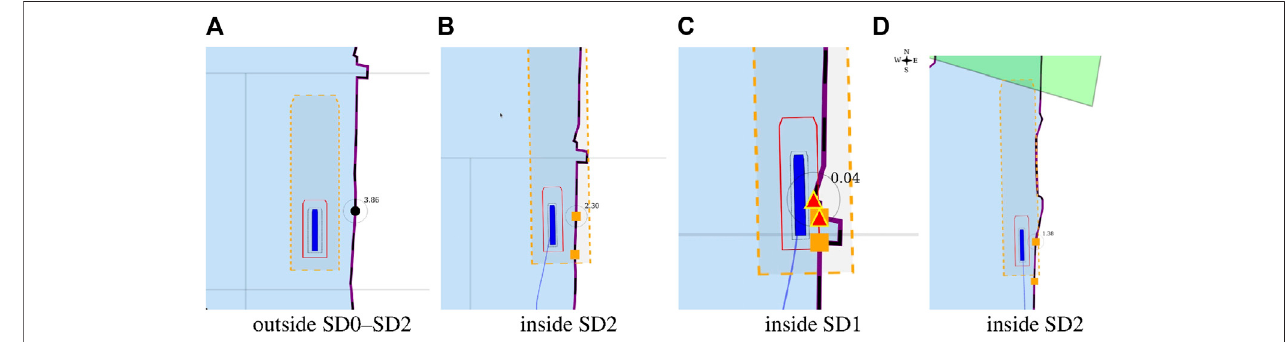
FIGURE 12 | Dynamic shortest distance between vessel and shoreline additions to MD0 via a main geometry – geometry